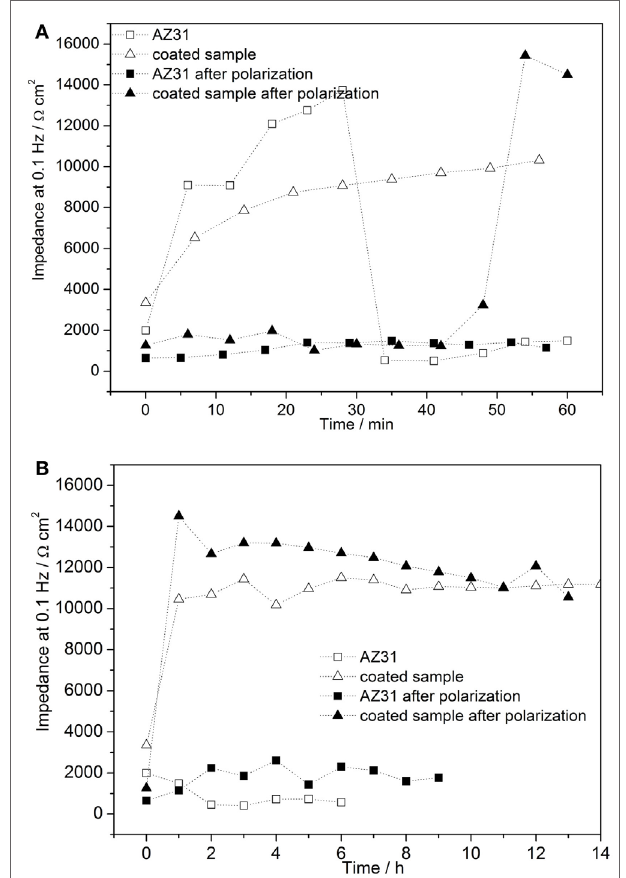
FigUre 9 | (a,B) Time dependent plots of impedance measurements of cerium oxide film after polarization of + 0.5 V vs. Eoc, immersed in 1 mM NaOH with 0.05M NaCl; (a) Bode plot of evolution during first hour; (B) Bode plot of hourly development.